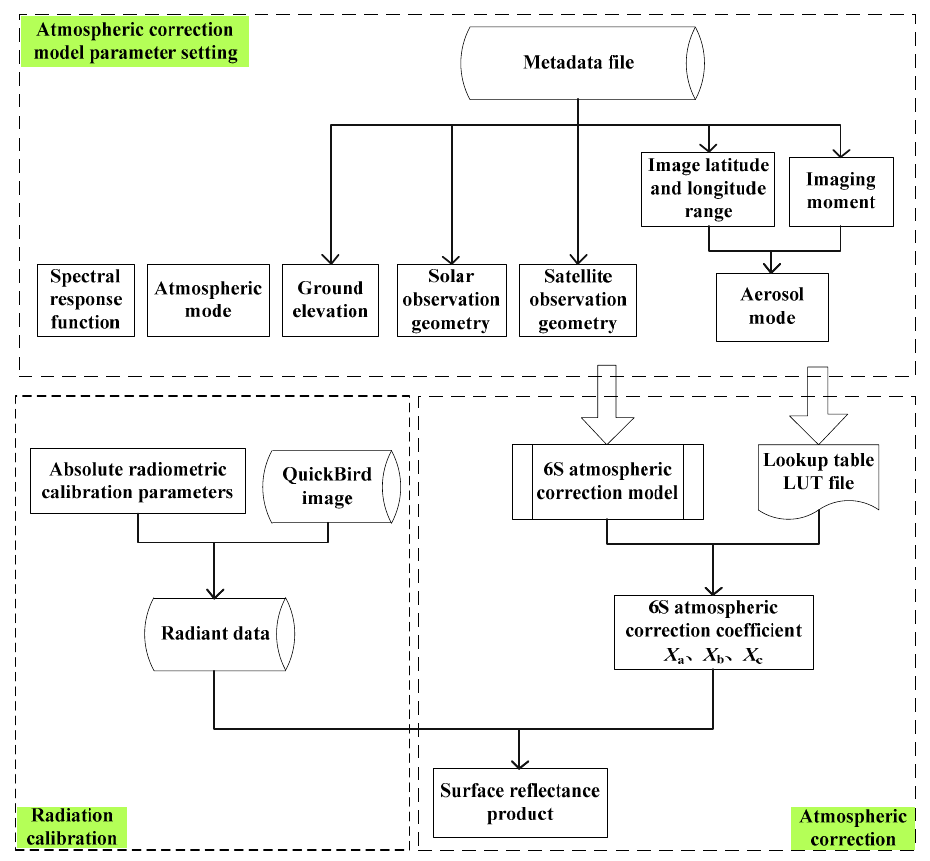
Figure 3. Technical route of the 6S atmospheric correction model.